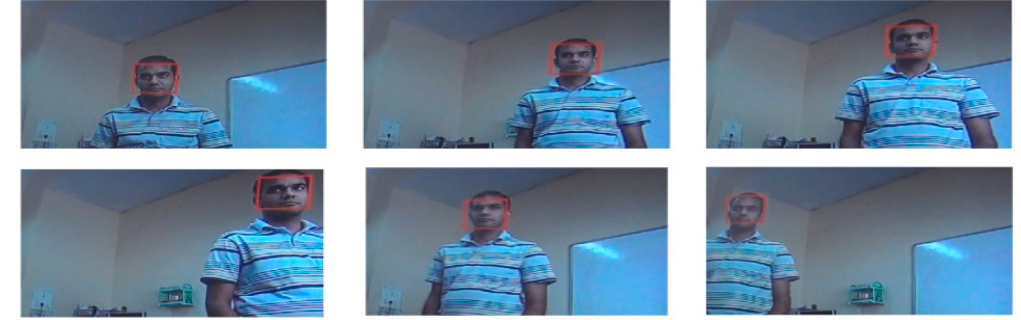
Figure 14. Frame sequence showing object tracking against static background.